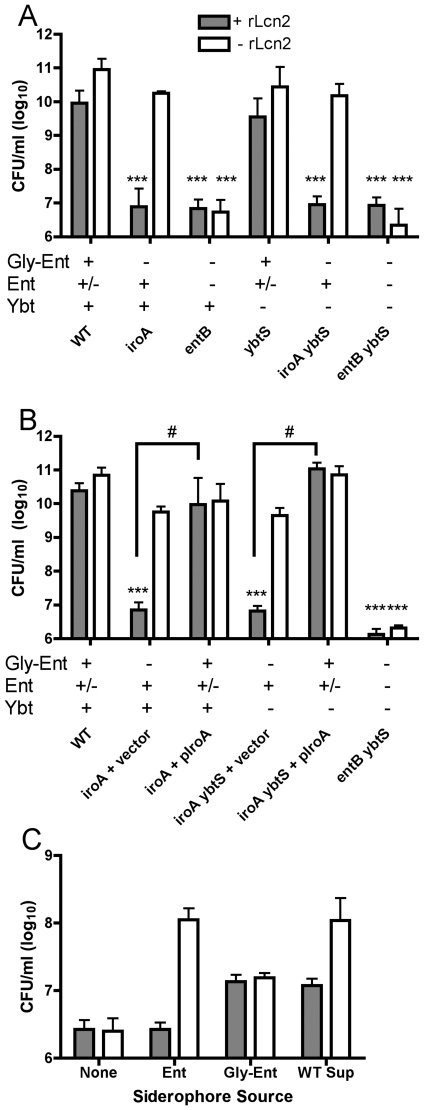
The iroA locus protects against growth inhibition by lipocalin 2.Overnight growth in Lcn2-deficient mouse serum with or without 1.6 µM recombinant Lcn2 was determined for the K. pneumoniae mutants indicated (A). For complementation studies, growth in serum was determined for the iroA and iroA ybtS mutant transformed with the vector control (pACYC184) or pIroA (pACYC184::iroBCDN) (B). Mean±SEM for at least three independent experiments is shown as log10 CFU/ml. Siderophores encoded by each mutant are indicated by a plus (+). *** p<0.001 comparing each condition to WT plus rLcn2, and # p<0.001 comparing pIroA to vector control, as determined by one-way ANOVA with Tukey's multiple comparison test. To determine if wild-type K. pneumoniae produces Lcn2-resistant and sensitive Ent, growth of the entB mutant in serum with or without 5 µM recombinant Lcn2 was compared between vehicle control, 16 nM of purified Ent or Gly-Ent (Salmochelin S4), or wild-type culture supernatant (1∶640 dilution) (C). Mean ± standard deviation for two independent experiments is shown as log10 CFU/ml.